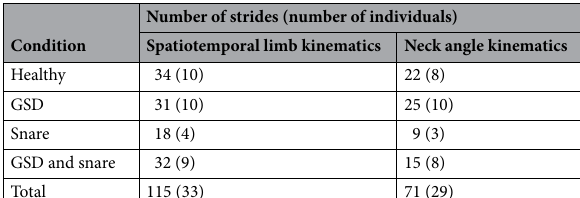
Number of strides (number of Condition